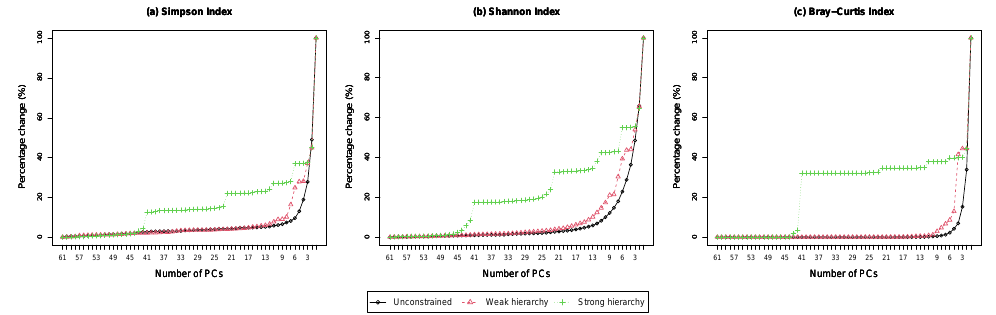
Figure 4. The NICU data: Scree plots for HPAA with ( a ) Simpson’s index, ( b ) Shannon’s index and ( c ) Bray-Curtis dissimilarity under different hierarchy settings (Percentage change in diversity vs. number of principal